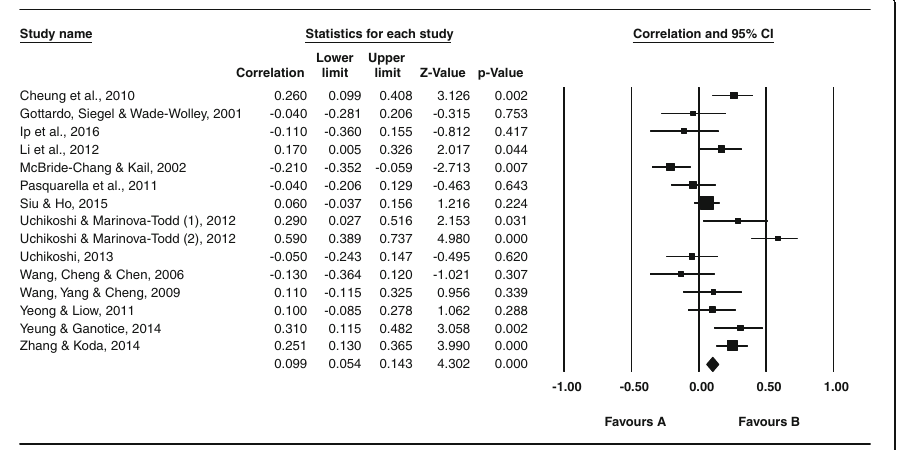
Fig. 3 Overall average correlation and correlation with confidence interval for each study correlating Chinese and English vocabulary. Note. Overall correlation shows at the bottom of the figure. Diamond shape = overall correlation average across listed studies on graph. Size of square reflects sample size, with bigger square representing a larger sample size (Cheung et al., 2010; Gottardo, Siegel & Wade-Woolley 2001; Ip et al., 2016; Li et al., 2012; McBride-Chang & Kail 2002; Pasquarella et al., 2011; Siu & Ho 2015; Uchikoshi &